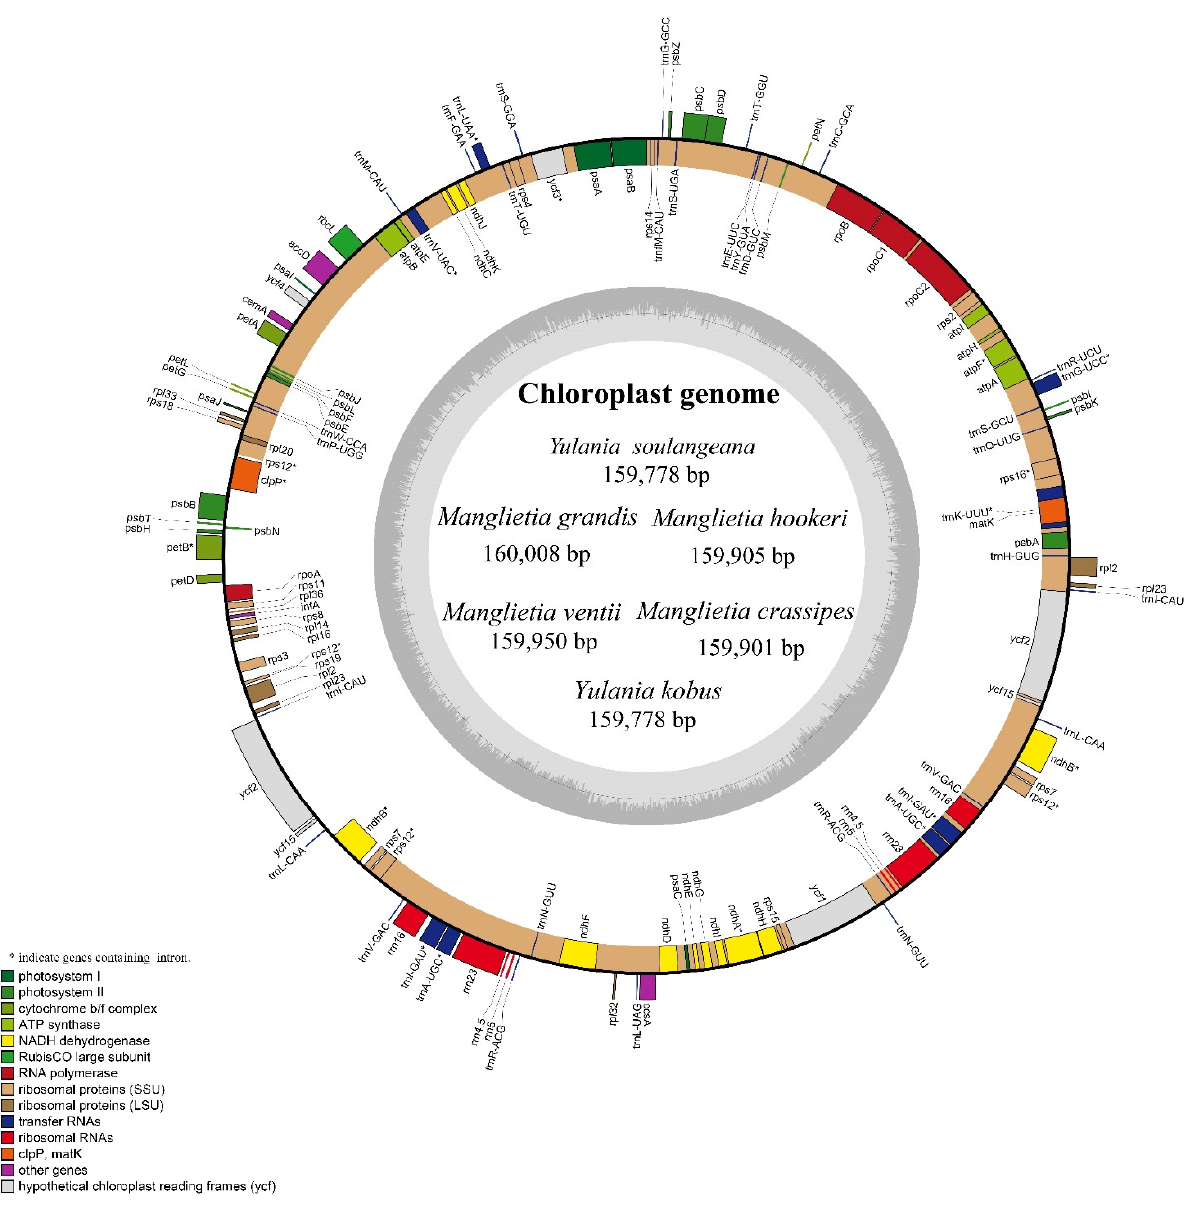
Figure 1. Structural map of the six chloroplast genomes of Magnoliaceae species. Table 2. Summary of chloroplast genome characteristics of six Magnoliaceae chloroplast genomes.